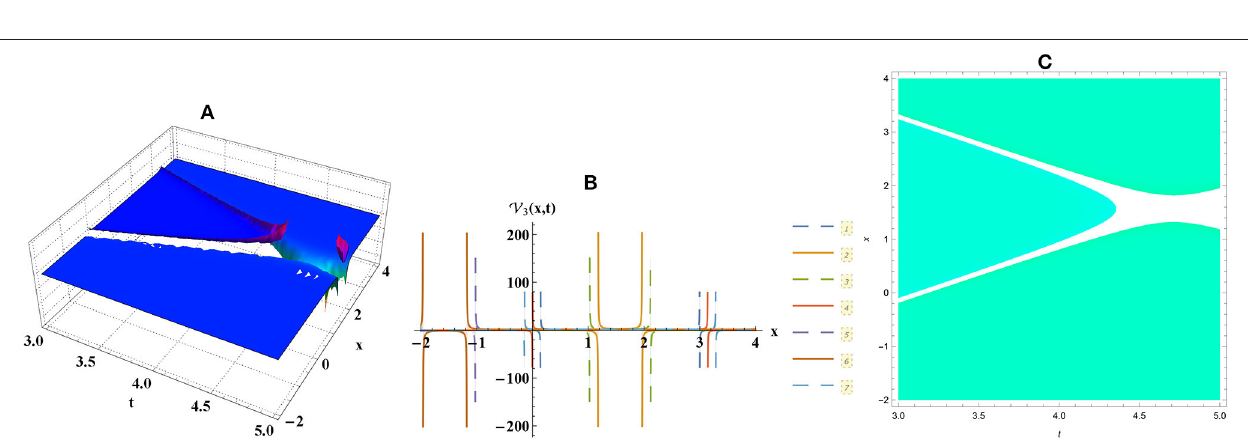
FIGURE 3 | Solitary numerical graph for Equation (7) through (A) three-dimensional, (B) two-dimensional, and (C) density plots.